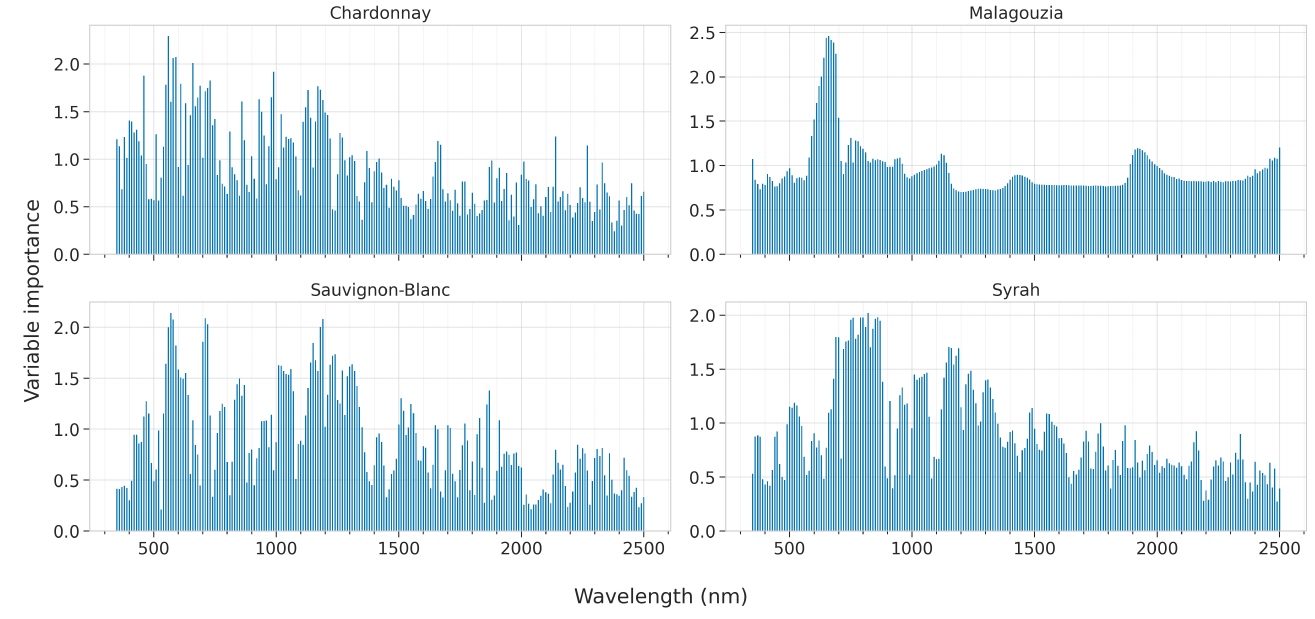
Figure 12. Mean feature importance according to Variable Importance in Projection values for the best PLS model across the five folds and for each of the four grape varieties; the higher the bar, the more informative the feature about the °Brix content.